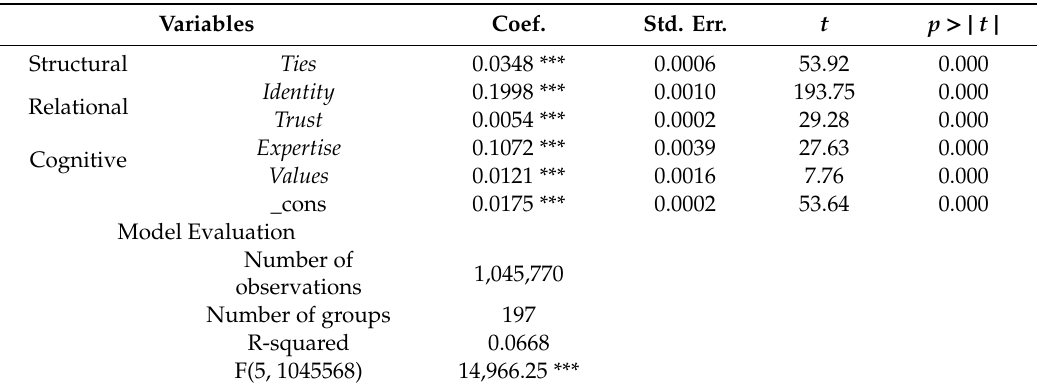
Table 4. Panel data regression